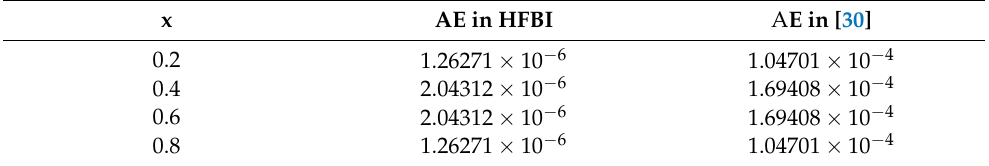
Table 5. Comparison of AE in HFBI with Extended Cubic B-Splines proposed by [30] for Problem 2.